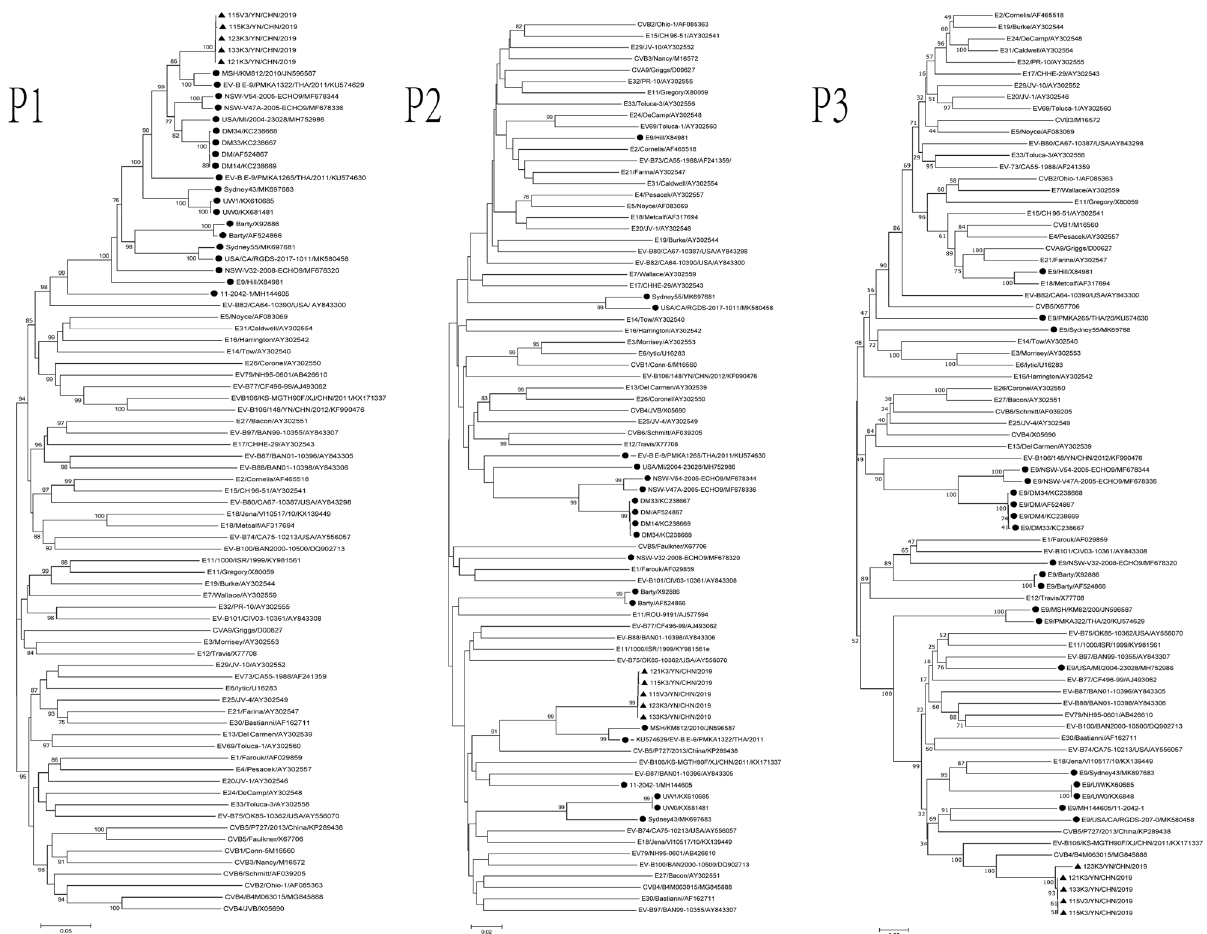
Figure 2. Phylogenetic relationships based on the P1 , P2 , and P3 coding sequences of all E9 strains, all EV-B prototype strains available in the GenBank database, the five Yunnan isolates, and three EV-B strains (CV-B5/ P727/2013/China, CVB4-B4M063015 and E11-1000/ISR/1999), as analyzed by nucleotide sequence alignment with the neighbor joining algorithms implemented in the MEGA 6.06 program. Numbers at nodes indicate bootstrap support for that node (percentage of 1000 bootstrap replicates). The scale bars represent the genetic distance. Only high bootstrap values (> 75%) are shown. Filled triangle: strains isolated in this investigation. Filled circle: E9